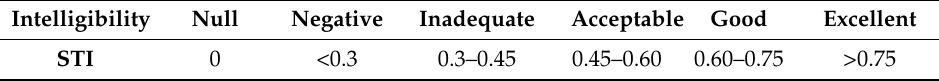
Table 3. STI reference values according to IEC